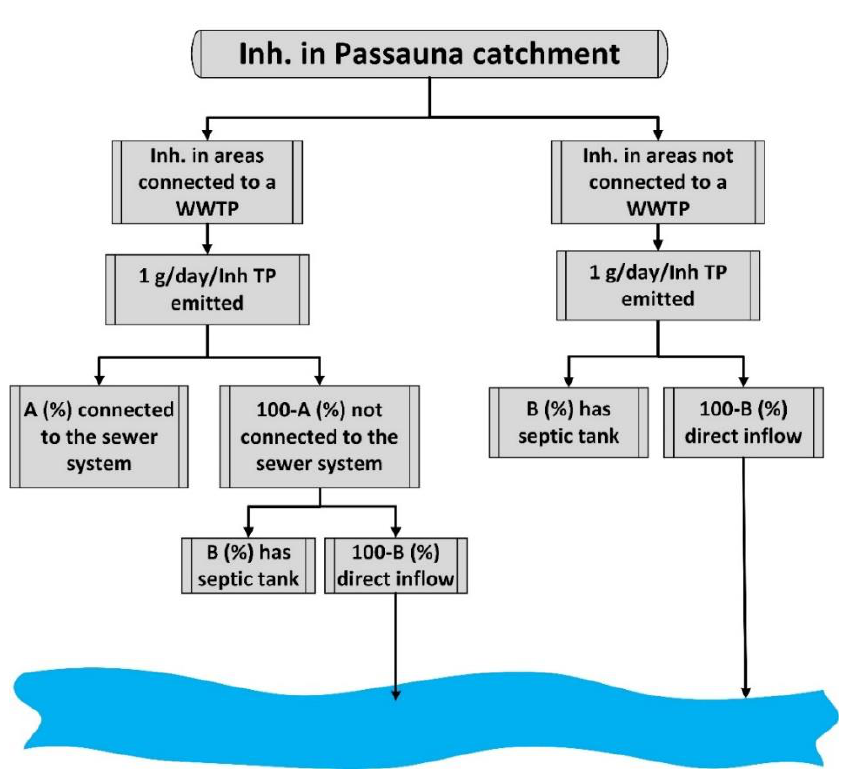
Figure 4. Schematic representation of the modelling approach.